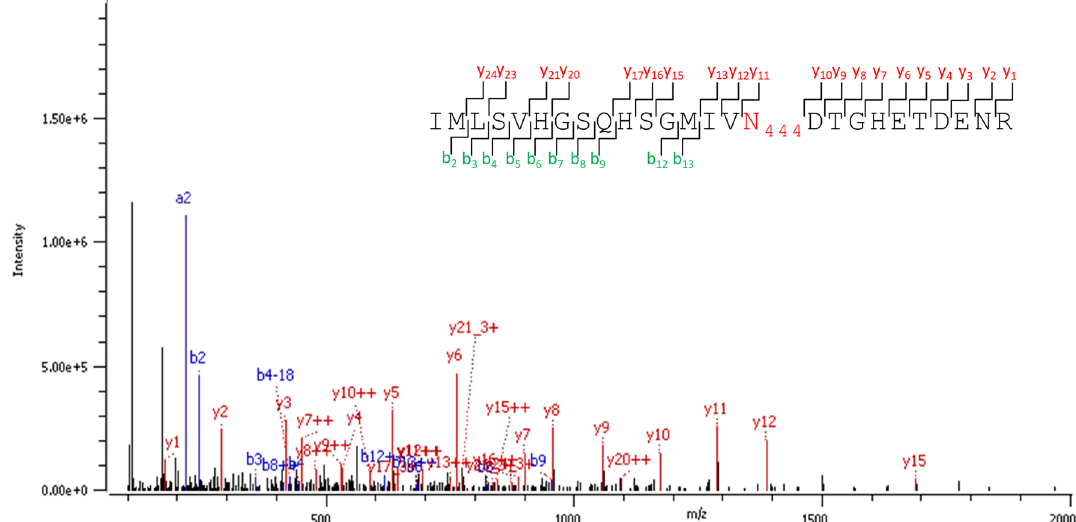
Figure 4. MS/MS fragment ion spectrum of the de- N -glycosylated and deamidated N -glycopeptide from the ZIKV E protein produced in EB66 cells. The fragment ion spectrum of the tryptic peptide IMLSVHGSQHSGMIVN(deamidated)DTGHETDNR after N -glycan release is shown. Diagnostic y-ions (red) and b-ions (blue) are annotated in the ion spectrum and highlighted in the peptide sequence at the upper right corner. The potential N -glycosylation site N444 is deamidated